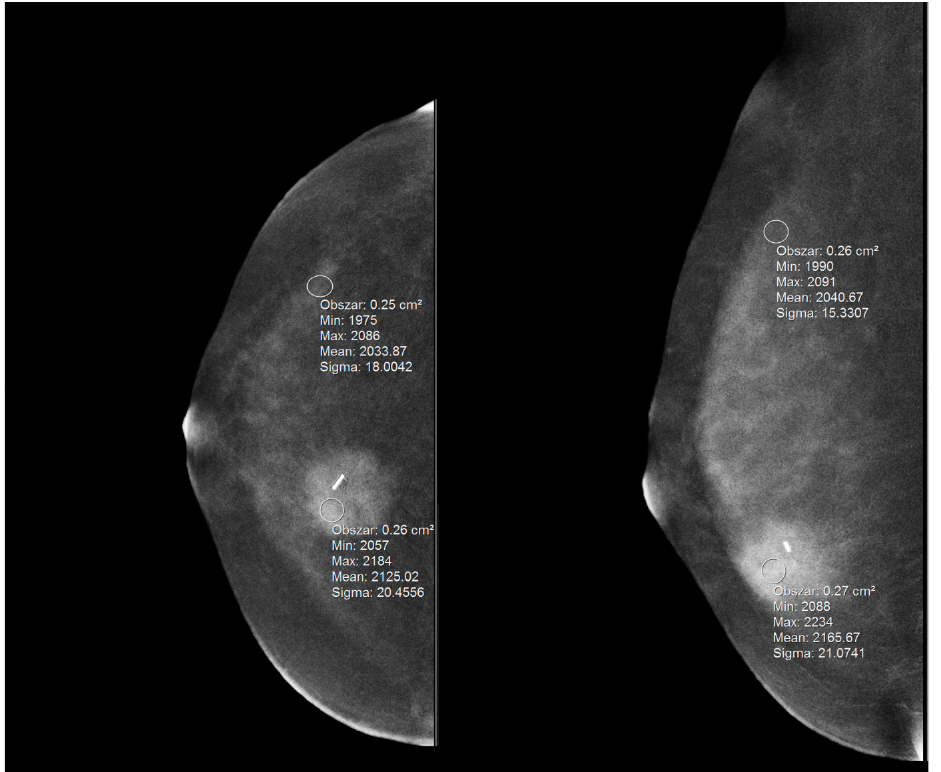
Figure 3. The method of measurement with the ROI within the focal lesion and BPE, presented on MLO and CC projections.